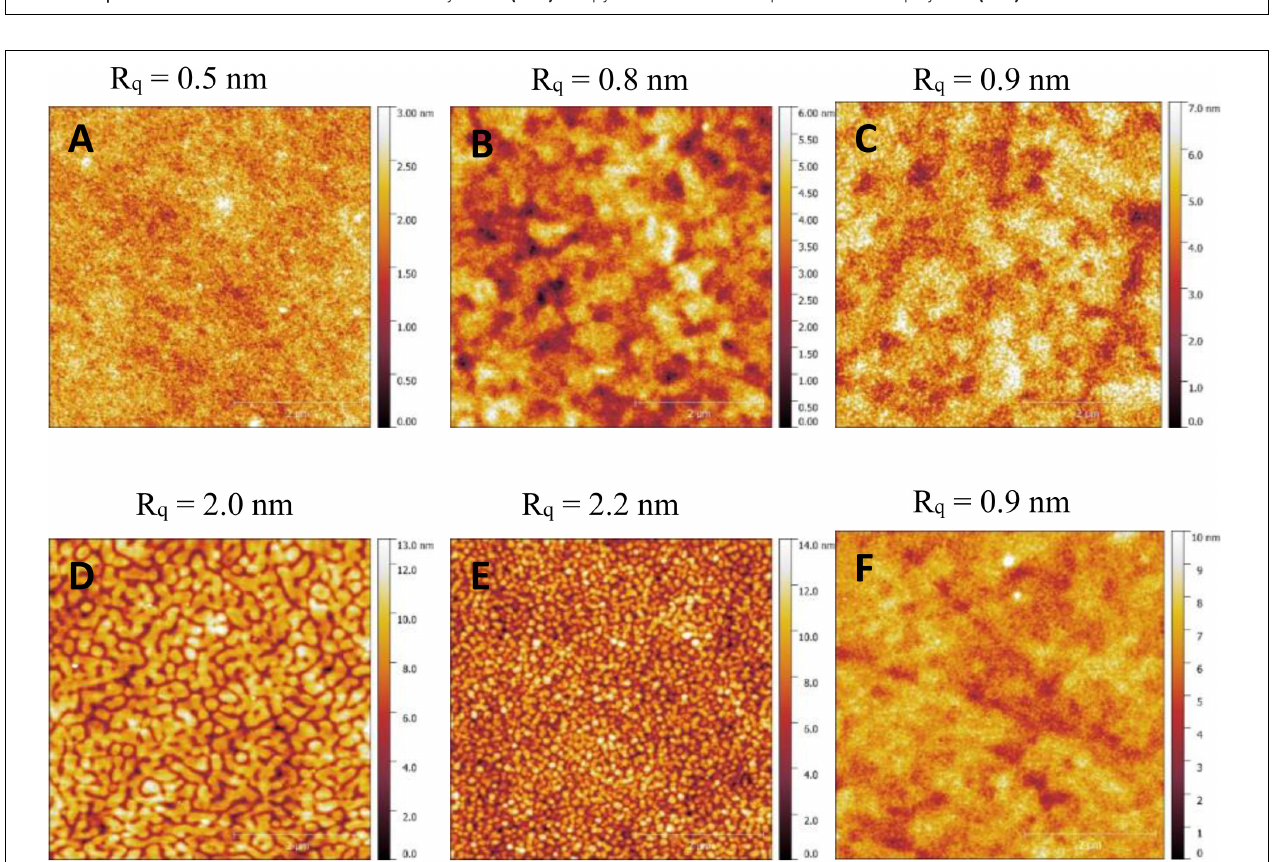
FIGURE 5 | Device characteristics as a function of tertiary amine (A–C) and pyridine content in the quinoxaline unit of polymers (D–F) .